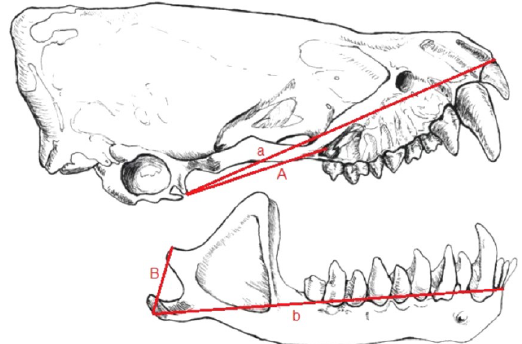
Figure 3. Distances used to measure maximum gape height. Maximum gape height was estimated using the distances between the posterior-most point of the temporomandibular joint and the anterior-most point at the upper incisors (a), lower incisors (b), and origin (A) and insertion (B) of the superficial masseter to estimate the maximum gape for each individual. Figure made by Sara Vukson.